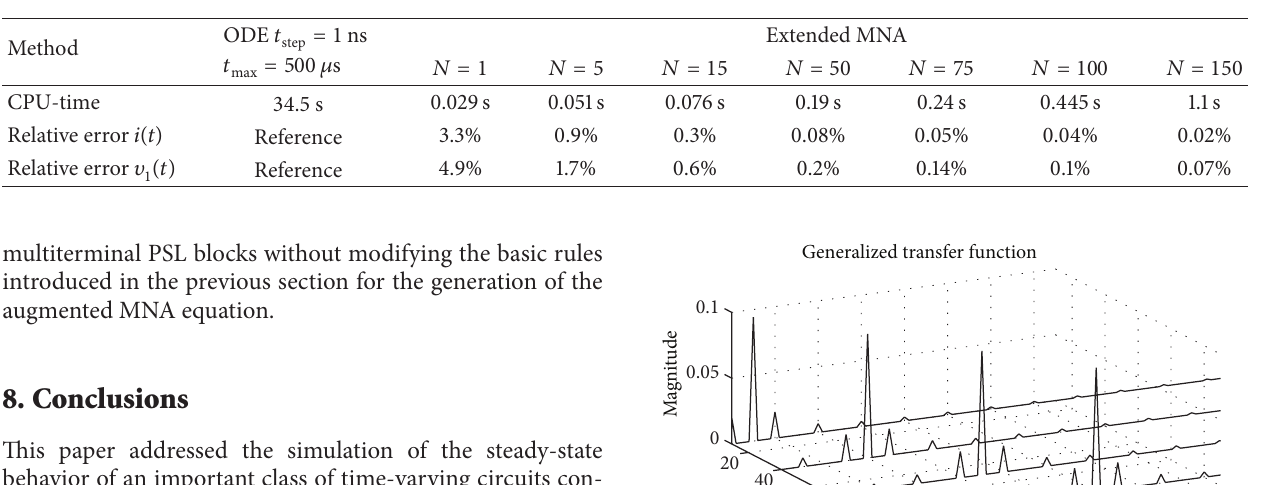
Table 2: CPU-time required by the simulation of the circuit of Figure 6 and accuracy of the computed current and voltage responses 𝑖 1 (𝑡) and 𝑣 2 (𝑡) , for an increasing number of terms 𝑁 defining their truncated expansions (e.g., see (23)).